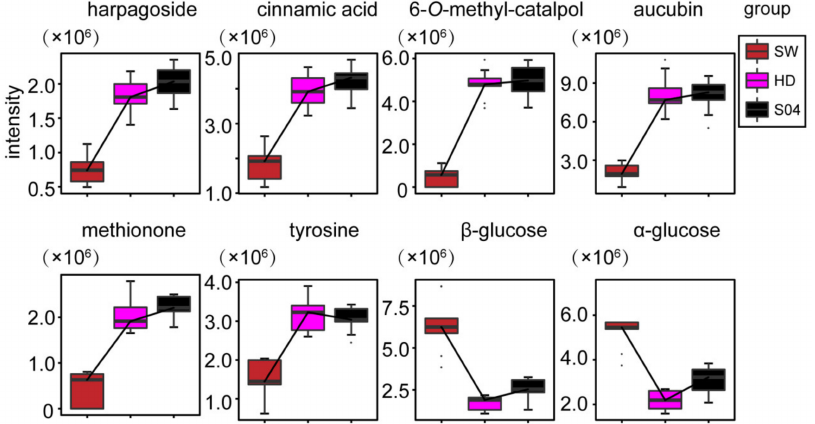
Figure 5. Boxplots of the relative intensities of seven identified differential compounds in samples processed using different methods, sweating (SW, claret), hot-air drying (HD, peach), and steaming for 4 h (S04,